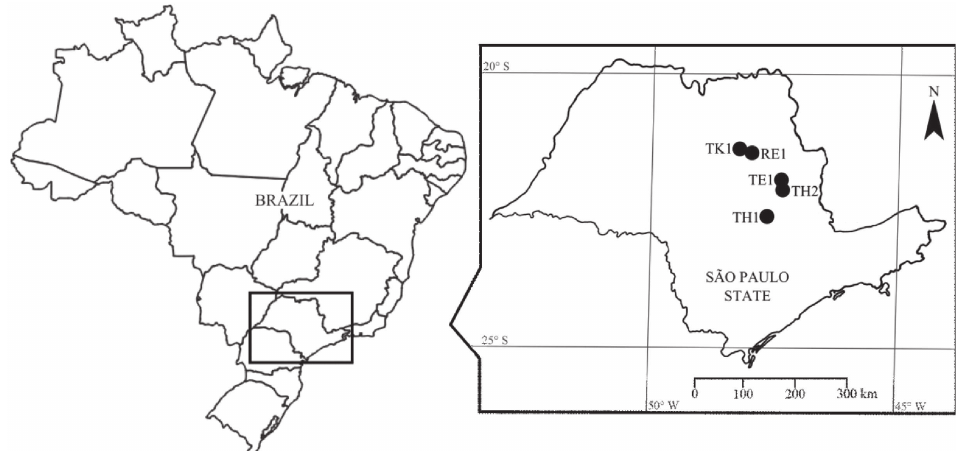
Figure 1. Locations of the soil sampling sites under sugarcane cultivation in São Paulo State, Brazil.